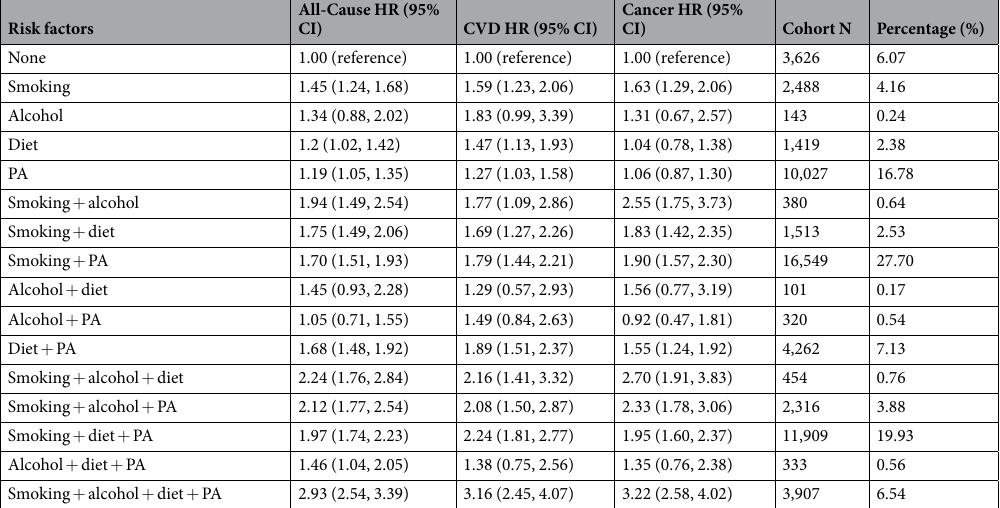
Table 5. Prevalence of all 16 combinations of lifestyle risk behaviors and adjusted hazard ratios for their associations with risks of all-cause, cardiovascular, and cancer mortality, the Shanghai Men’s Health Study (2002–2013, n = 59,747). HR: Hazard ratioe. Adjusted for age group, education, income per person, occupation, history of hypertension, diabetes mellitus, coronary heart disease, and stroke. CI: Confidence interval; N: number; PA: physical activity. 0: Not at risk; 1: At